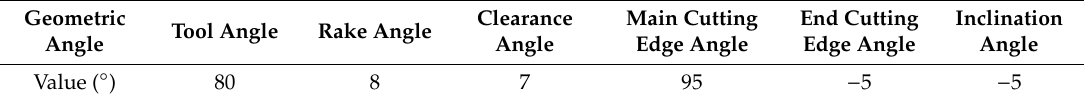
Table 1. Geometric and working angles of the micro-groove tool.